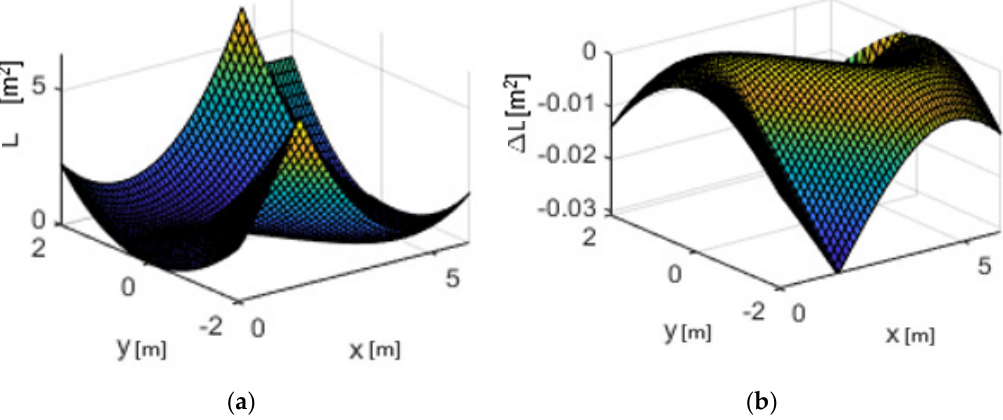
Figure 8. Results of the simulation: ( a ) The values of L in all the space; ( b ) The values of Δ L in all the space.